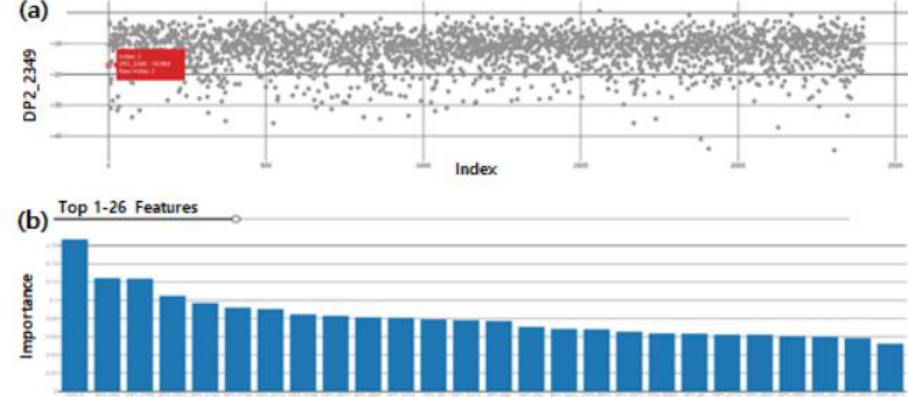
Figure 10. Model variable validation evaluation process; ( a ) local feature importance graph and ( b ) affected feature to model prediction list.